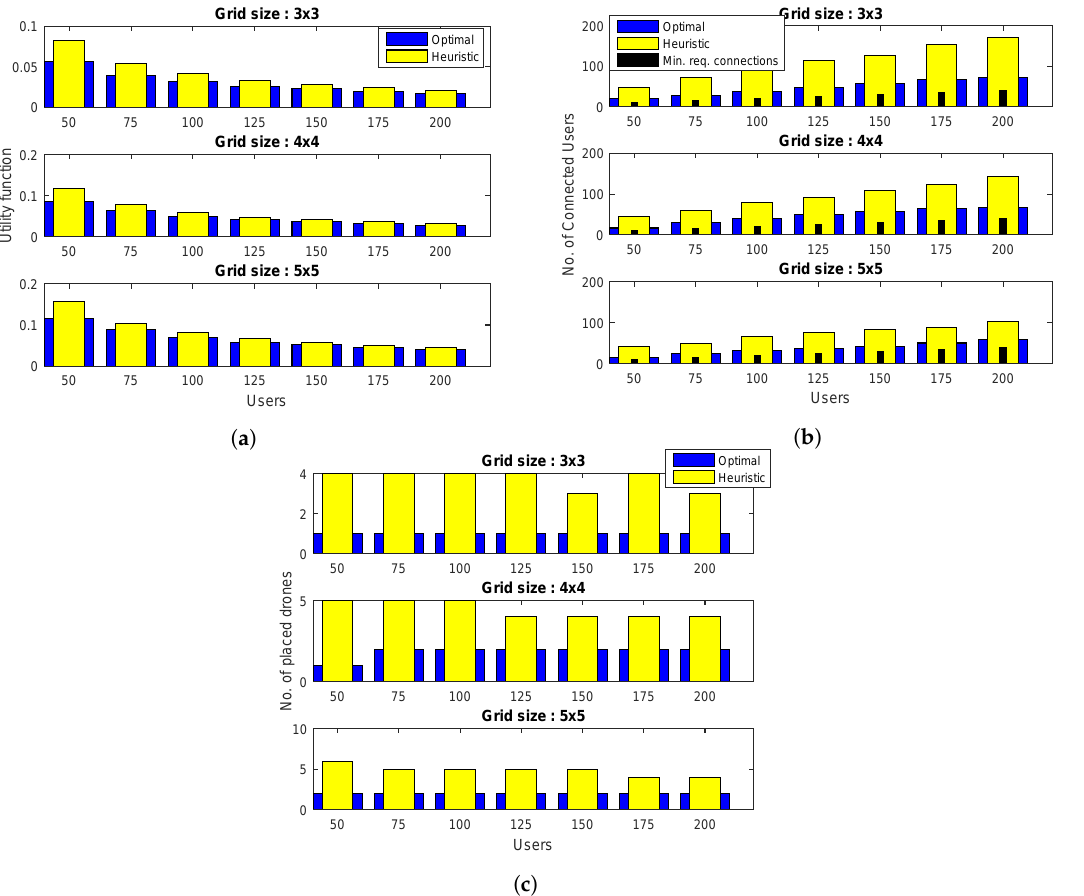
Figure 2. Comparison of proposed heuristic with the optimal algorithm for β = 0.2 and different grid sizes, in terms of: ( a ) The total number of connected users, ( b ) total number of placed drones, and ( c ) the utility value, that is, the ratio of the total number of placed drones to the total number of connected users.